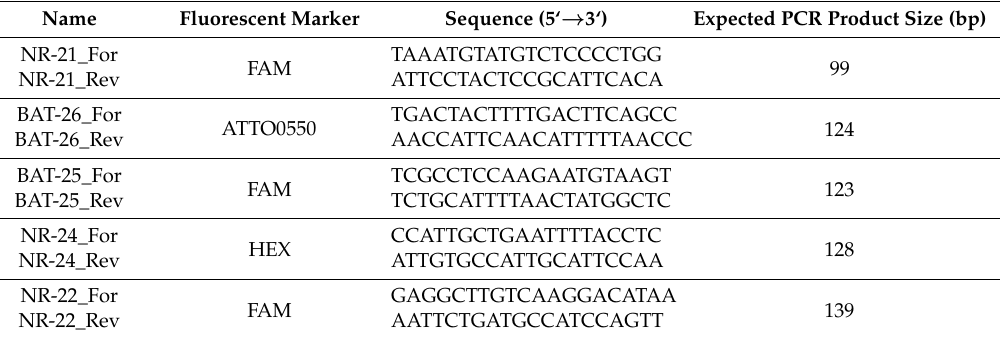
Table 3. Primer for MSI